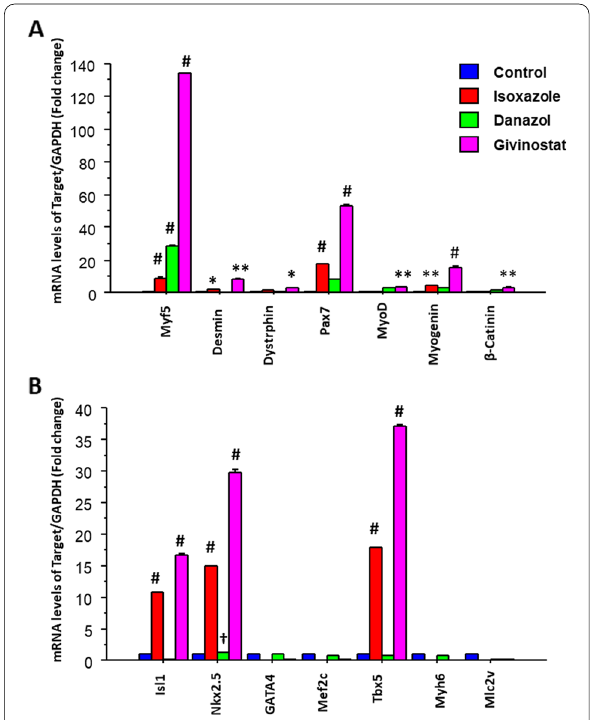
Fig. 2 Givinostat has dual expression of cardiac/skeletal myogenic genes: GIV increased upregulation of cardiac/skeletal myogenic genes (Real Time PCR Assay) versus ISX9, DAN and control after 7 days. A Muscle genes included Myf5, Pax7, MyoD1, myogenin, dystrophin, desmin and β-catenin. B Cardiac gene included Isl1, Nkx2.5, Tbx5, GATA4, Mef2c, Myh6 and Mlc2v. Values are mean SE; ± n 3; † P- value < 0.05, * P- value 0.01, ** P- value 0.001, # = = = P- value 0.0001 are =